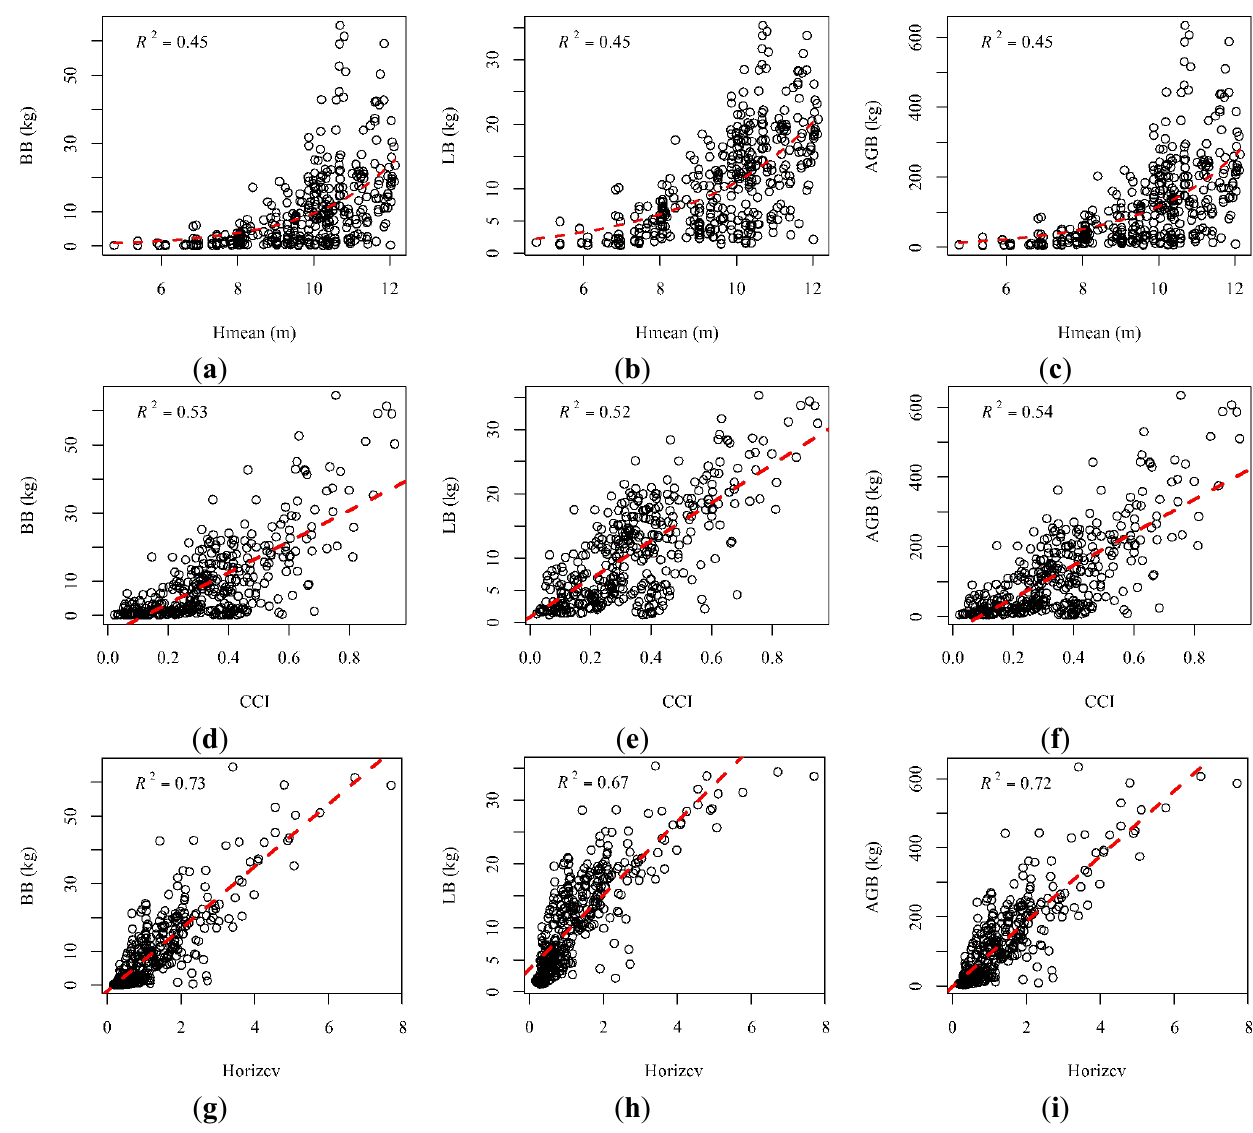
Figure 5. Scatter plots for biomass components (branch biomass (BB) ( a , d , g ), leaf biomass (LB) ( b , e , h ) and aboveground biomass (AGB) ( c , f , i )) and LiDAR metrics (mean height (H ) canopy cover index (CCI) and horizontal distribution of point clouds mean (Horiz )) at the individual tree cv